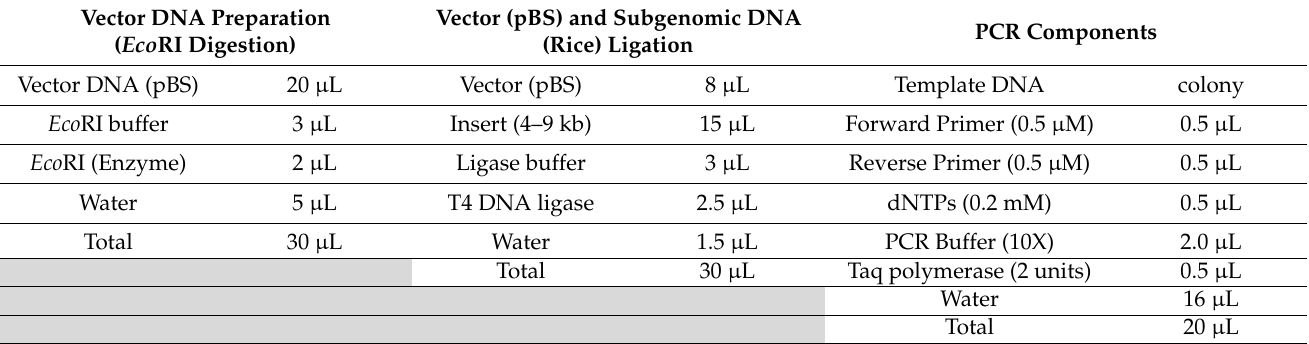
Table 1. In vitro conditions and constituents for cloning: restriction digestion ( Eco RI) of pBluescript, and ligation of vector DNA with subgenomic rice fragments and PCR components for colony PCR verification of recombinant clones.